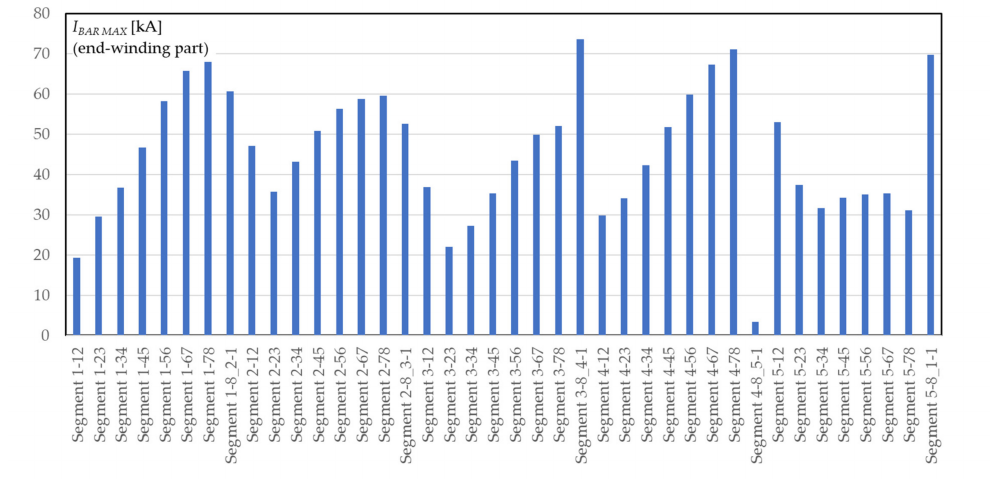
Figure 19. Distribution of maximum values of currents induced in rotor’s circuited segments during out-of-phase synchronization of − 120 ◦